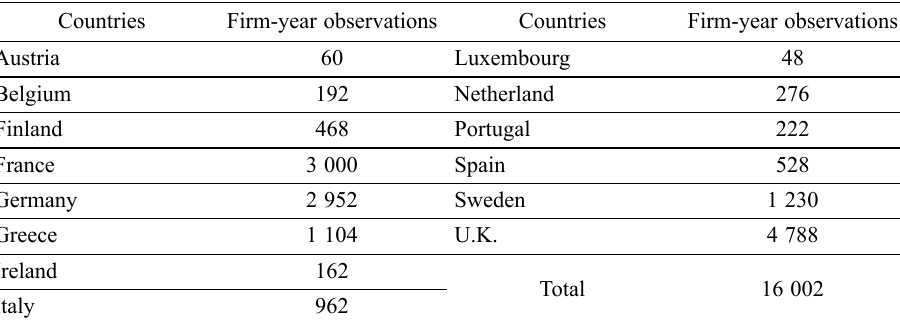
Table 1. Geographical portrait of the firm-year observations analysed